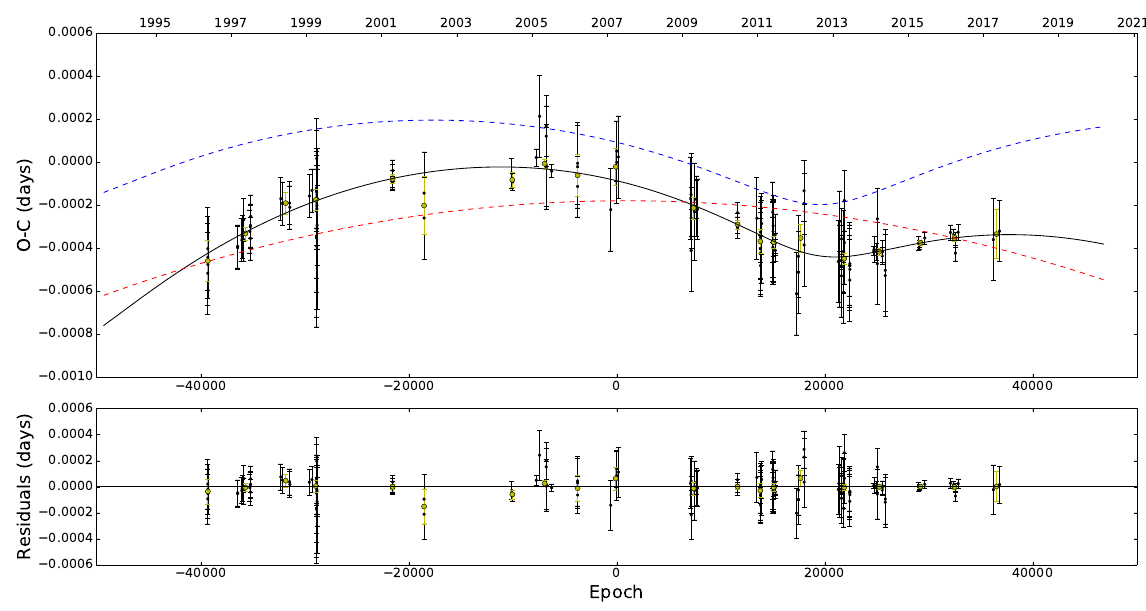
Figure 3. Eclipse Timing Variation (O-C) of the NY Vir and our own models, parabolic variation (in red) and periodic variaton (in blue), sum of both variatons (in black). Parameters of our fits are given on the upper right corner of the plot.